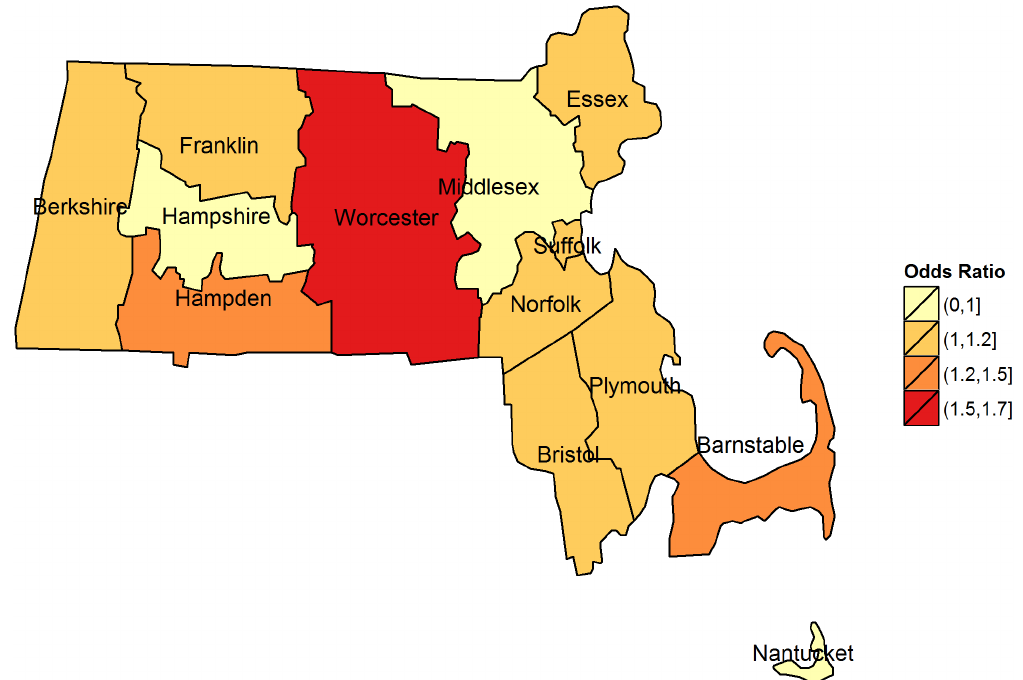
Figure 5. Odds ratios for emergency room visits for acute gastrointestinal symptoms in the 0–4 days following a flood by county, 2003–2007. (No floods occurred in Dukes County, odds ratios were not calculated).